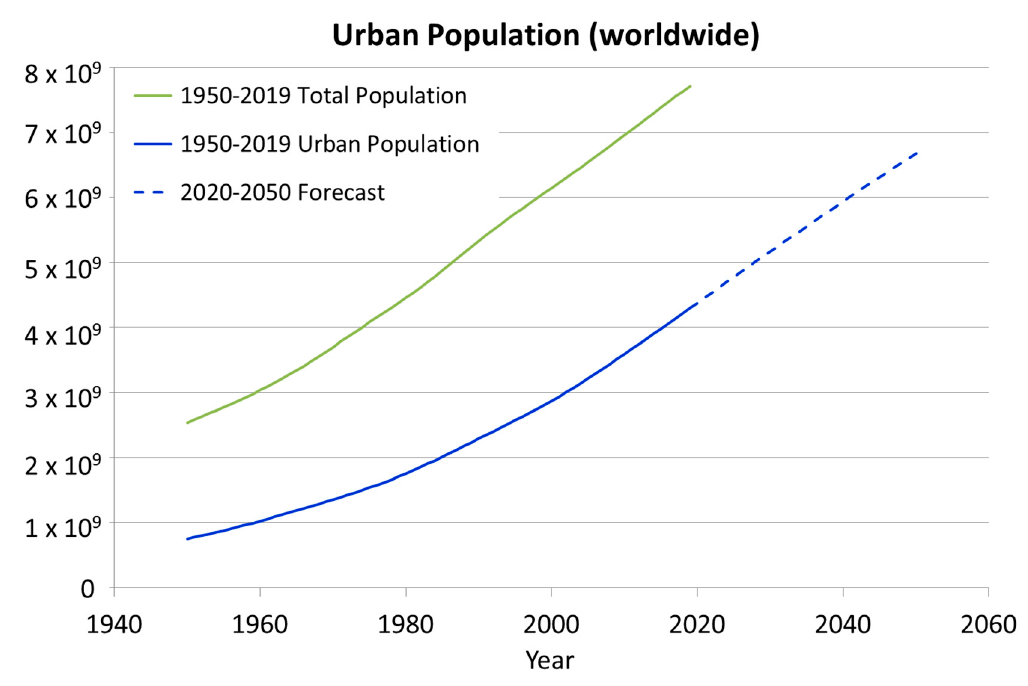
Figure 1. Development of the global population in cities [1].